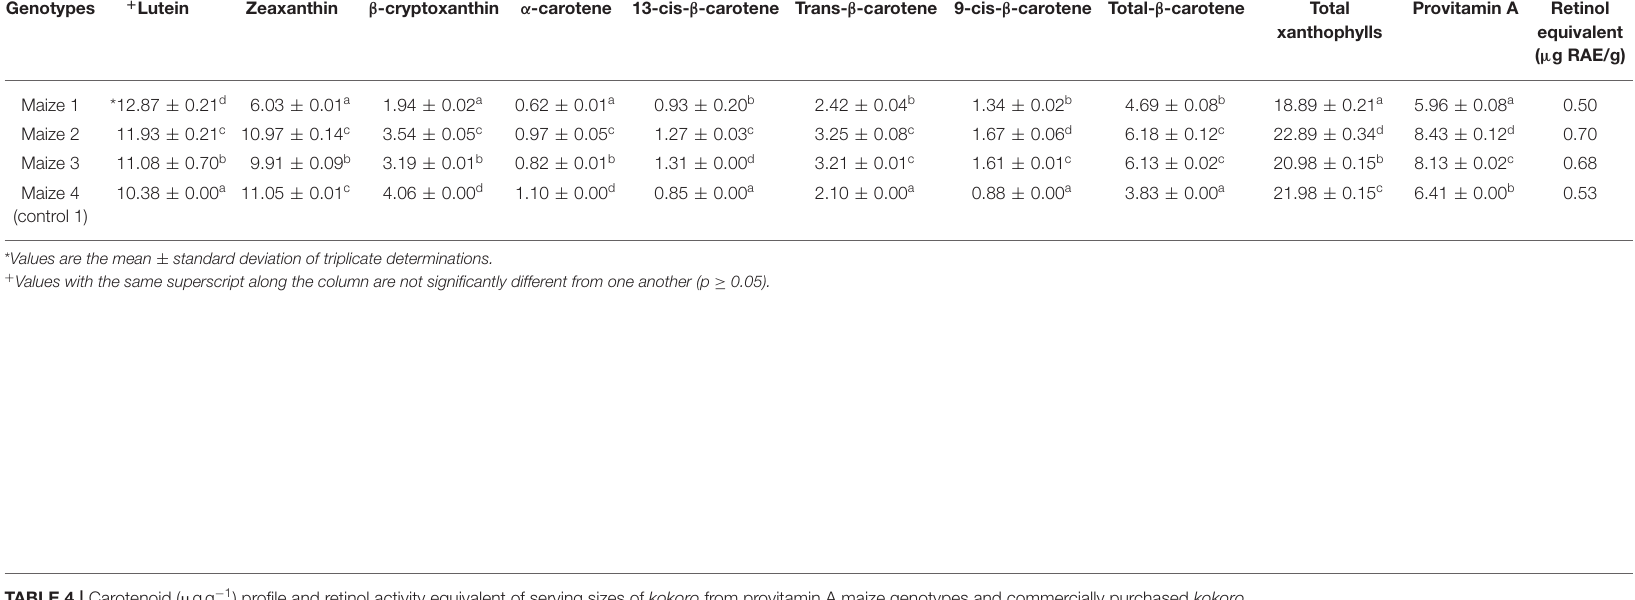
TABLE 4 | Carotenoid ( µ gg − 1 ) profile and retinol activity equivalent of serving sizes of kokoro from provitamin A maize genotypes and commercially purchased kokoro . Products